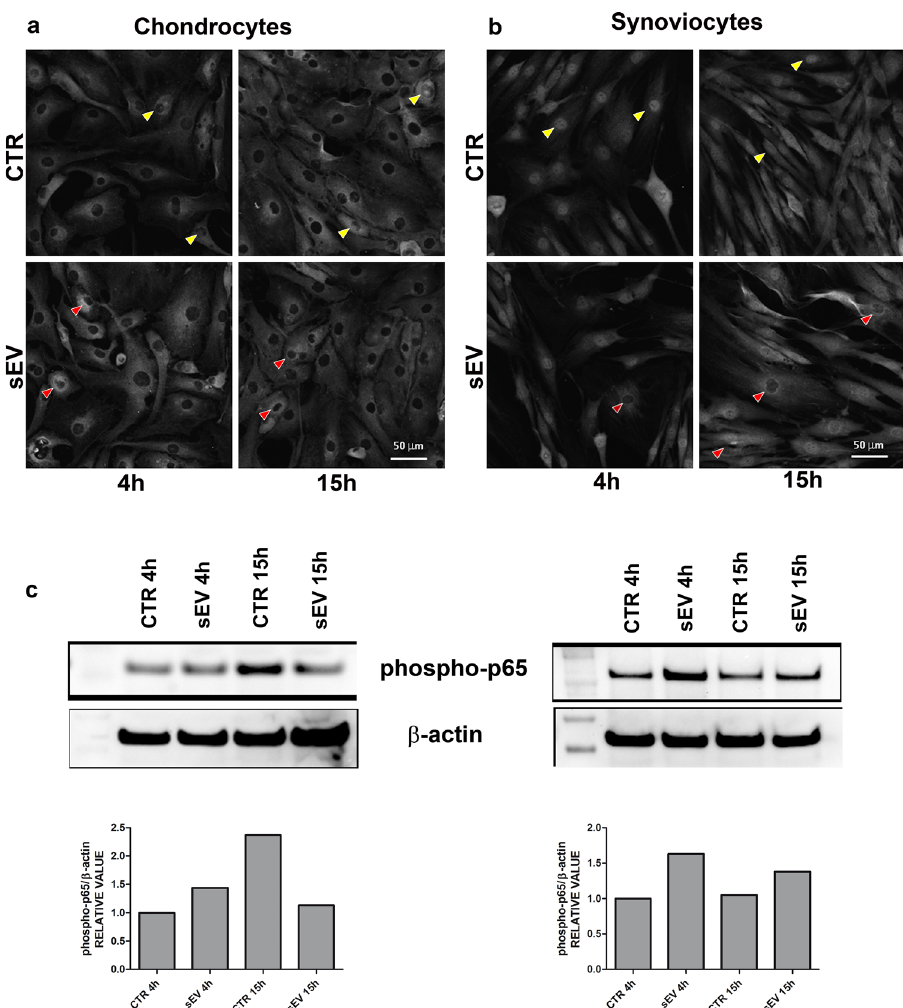
Figure 5. p65 immunofluorescence on chondrocytes ( a ) and synoviocytes ( b ) at 4 and 15 h in CTR (IL-1β treated) and sEV (IL-1β + sEV treated) conditions. Scale bar: 50 μm. Yellow arrows: p65 nuclear localization has a marked different pattern in chondrocytes and synoviocytes. Red arrows: p65 localization mainly excluded from the nuclei in some chondrocytes and synoviocytes at 4 and 15 h following sEV addition to cultures previously treated with IL-1β. ( c ) Western blot analysis of samples of chondrocytes (left) and synoviocytes (right) treated as those shown in ( a ) and ( b ), but dedicated to western blot analysis of phosphorylation of p65 and β actin as loading control (full blots available in supplementary Figs. 6 and 7) Lower graphs: relative quantification of phospho-p65 signal normalized to that of